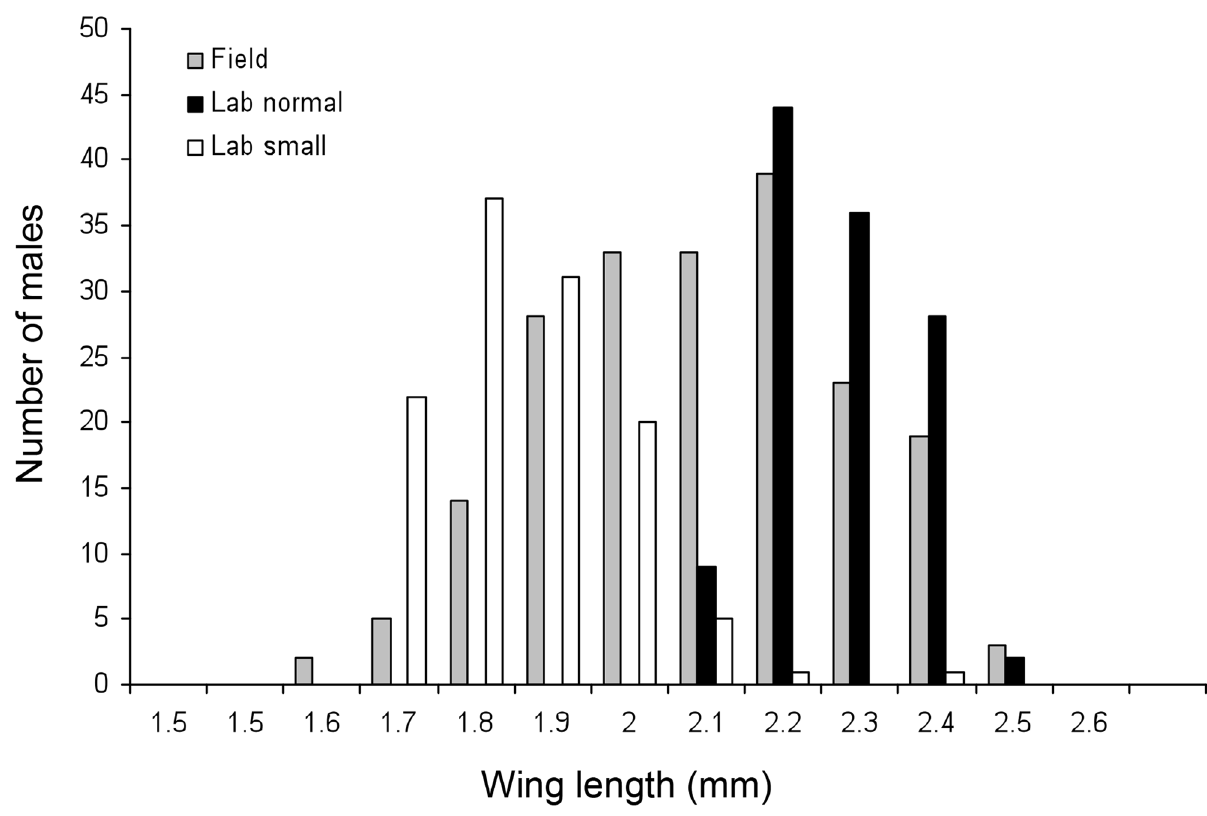
Figure 3. Male body size in the different rearing groups. Distribution male body size (estimated as wing length) for a sample of large lab reared males (fed ad libitum , n=119), small lab reared males (fed 1/4 the amount of food, n=117) and males trapped from the field during Nov-Dec 2012 (n= males).